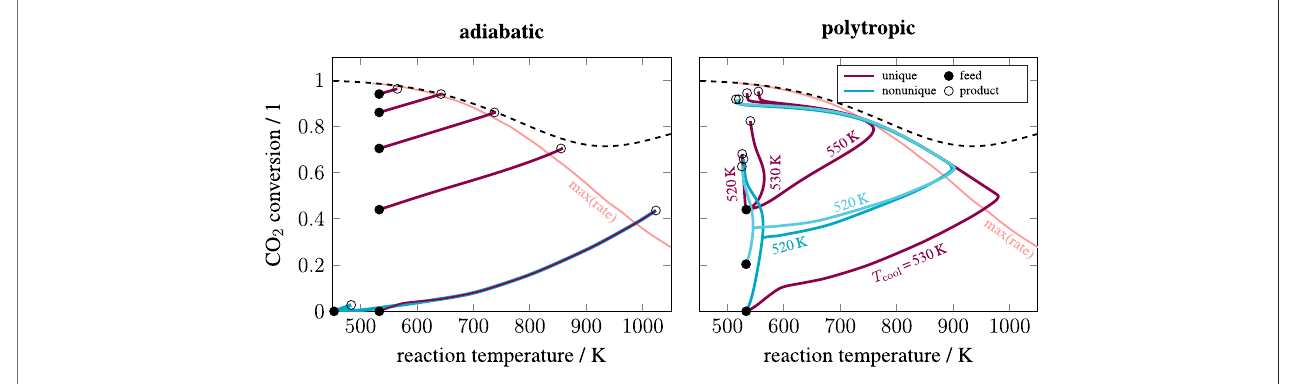
FIGURE 2 | State-space diagram for adiabatic and polytropic reactors with exemplary reaction pathways, reactor length: 2 m, pressure: 5 bar, reaction: CO 2 methanation according to Koschany et al. (2016), equilibrium CO 2 conversion ( ⁃ ⁃ ⁃ ⁃